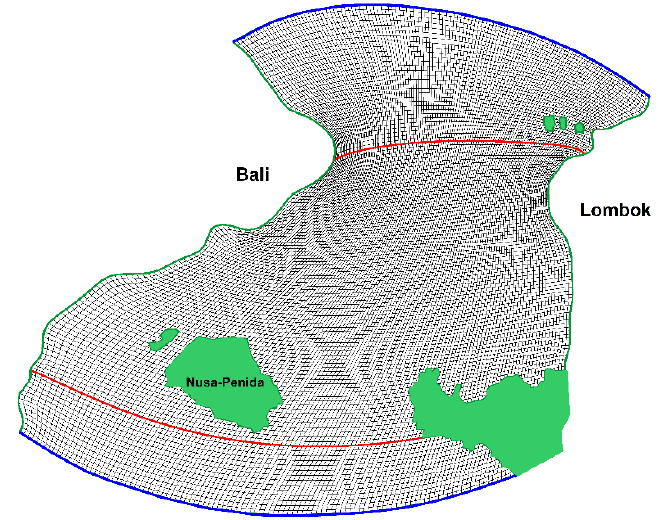
Figure 3. The computational grid 121 × 121 × 71; ∆ max = 1340 m, ∆ min = 315 m. reen line represents the solid boundary, blue line represents the open boundary and red line represents the domain with Nh pressure.